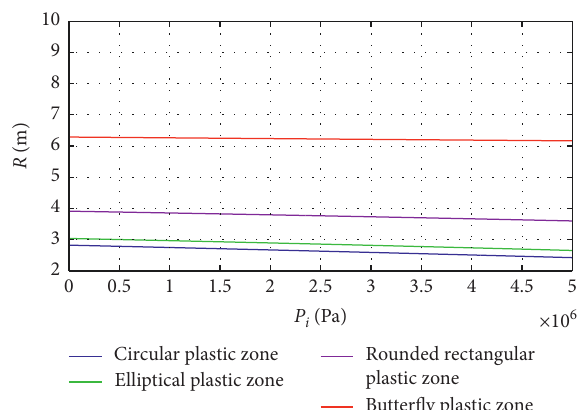
Figure 13: Relationship between tunnel radius and radius of plastic